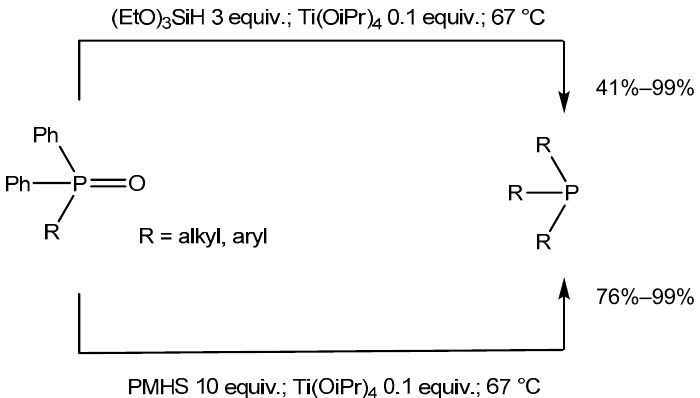
Scheme 3. Ti-catalysed phosphine oxide reduction using (EtO) 3 SiH or PHMS [13].